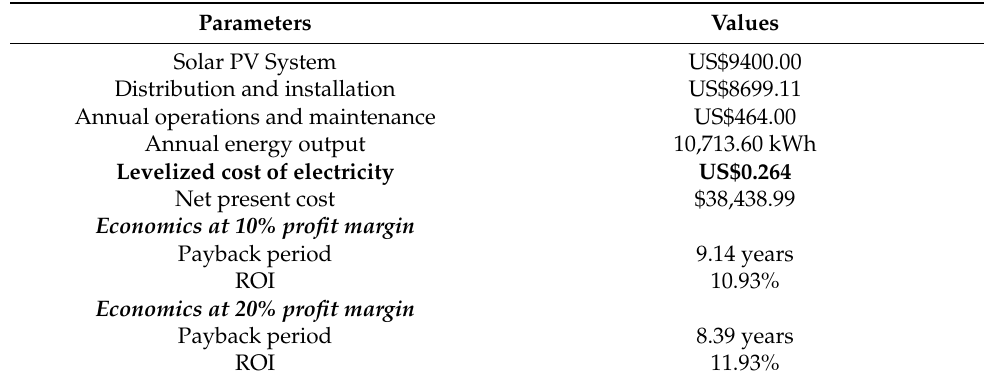
Table 7. Economic results for Gilutongan